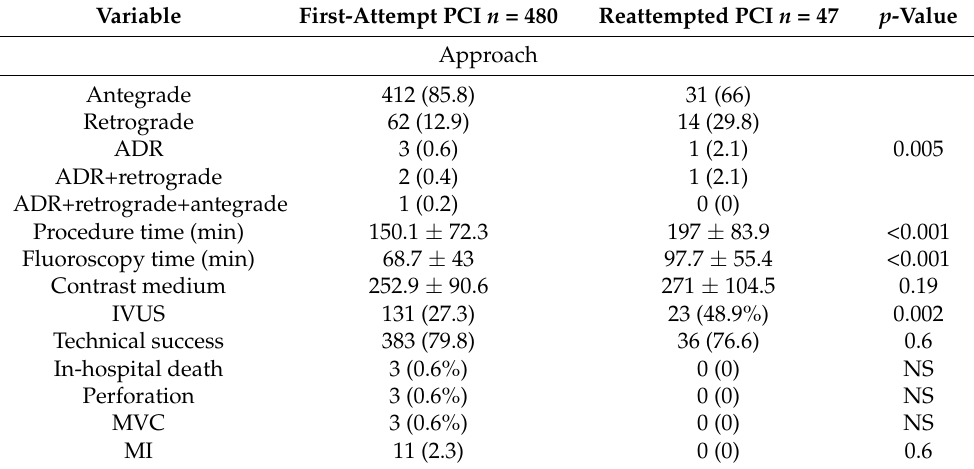
Table 3. Technical approach and procedural outcomes comparison between first attempt and reat- tempted